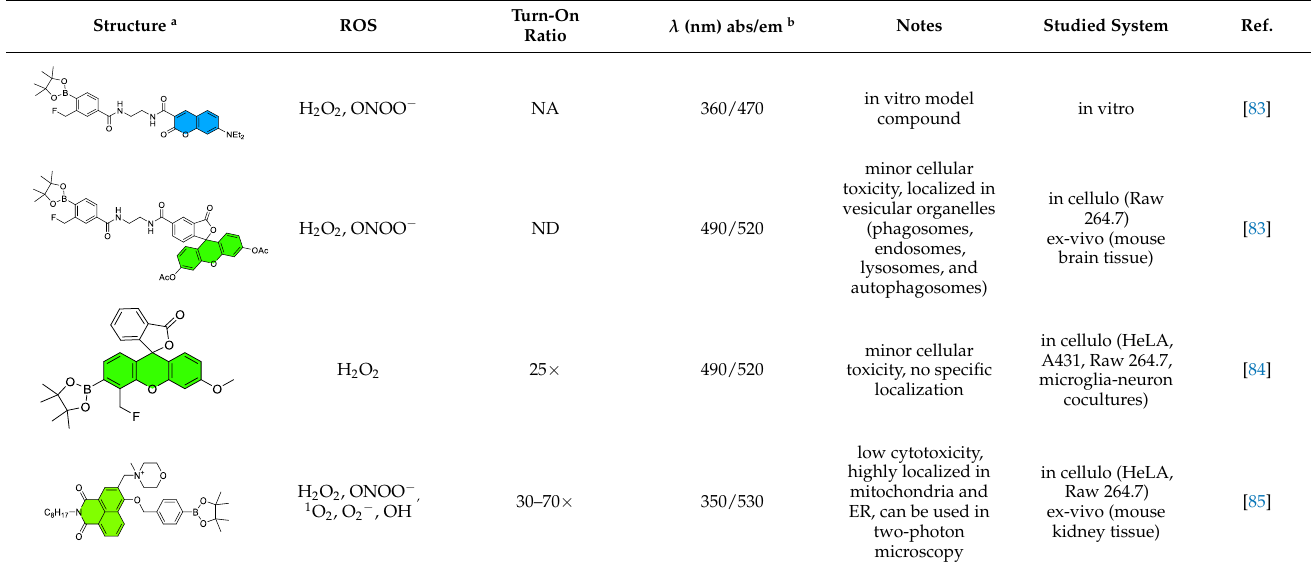
Table 11. ROS Table 11. ROS probes. Table 11. ROS probes. Table 11. ROS probes.